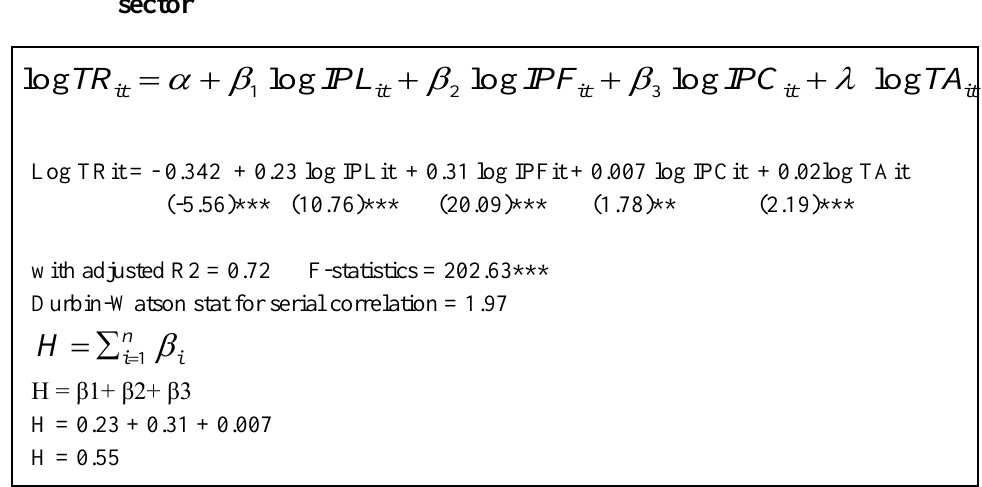
Table 1: Equation 2b - Test of competitive conditions of Sri Lankan banking